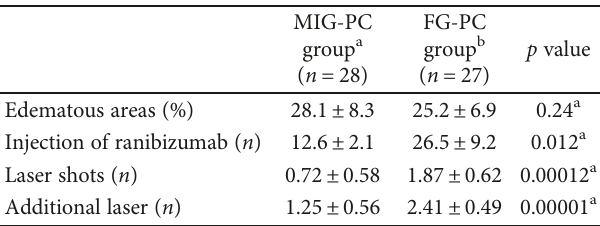
Figure 3: A sample of the MIG-PC method. (a) FA image shows the MAs as dots of hyper fl uorescein. (b) The OCT map image is merged with the FA image and fundus photograph. (c) High-magni fi cation image corresponding to the rectangle area is indicated with white-dashed line in Figures 3(b) and 3(d). MAs were noticed in the thickened retinal area. (d) MAs are marked as yellow circles on the ocular fundus photograph. (e) High-magni fi cation image corresponding to the rectangle area is indicated with white-dashed line in Figure 3d. Table 2: Data relating